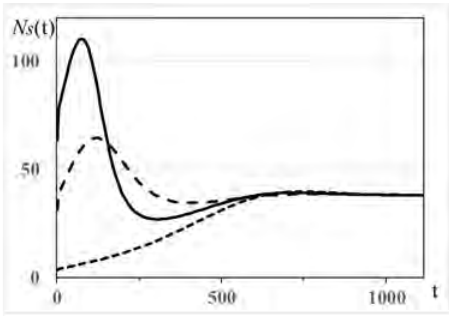
( C ) , δ (1) ( C ) , - - - graphs of H C